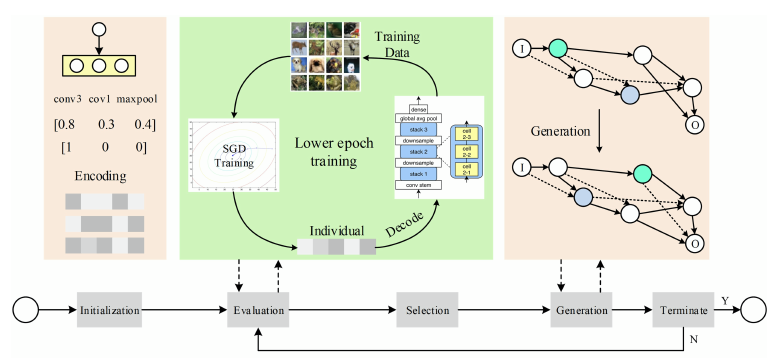
Figure 1. Pipline of the QDO-NAS Figure 1. Pipeline of the QDO-NAS.